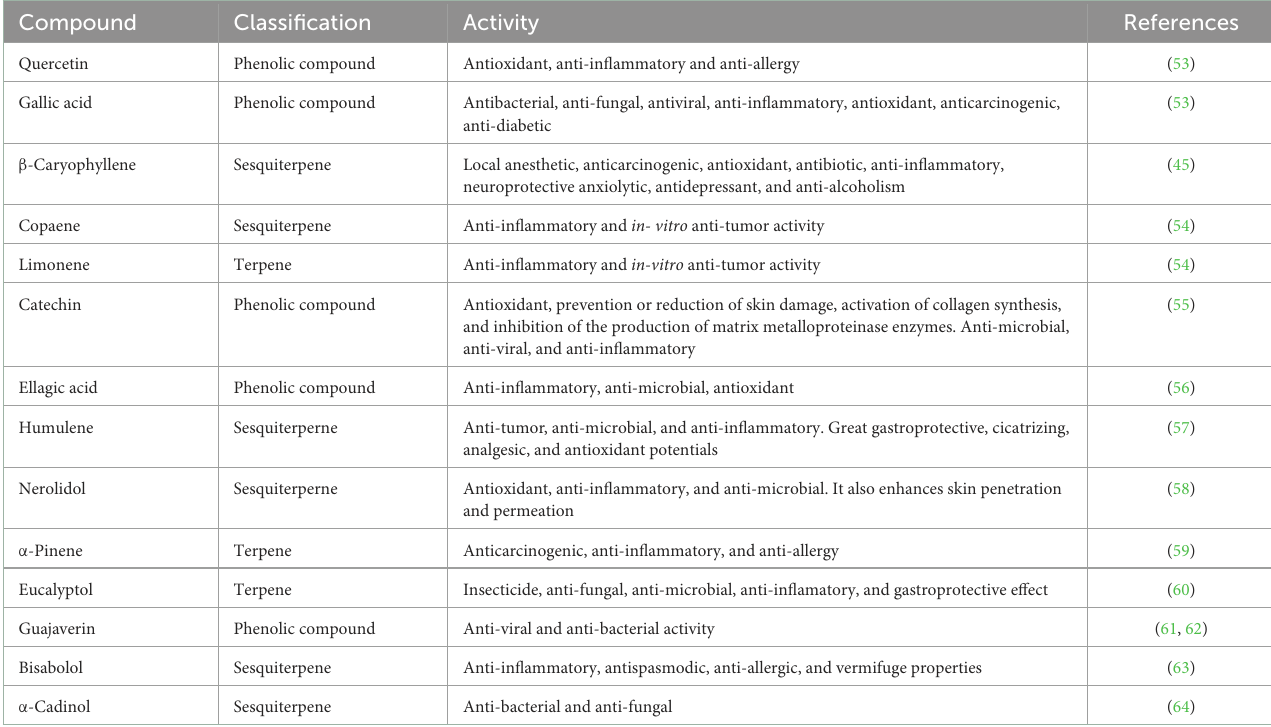
TABLE 2 Bioactivity of different compounds found in Psidium guajava L.